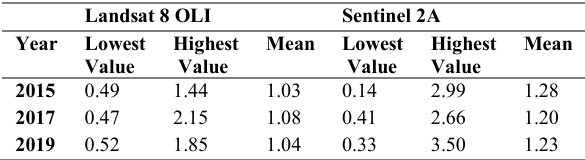
Table 7: MSI Value Ranges for Landsat 8 and Sentinel 2A 3.6 Comparative Analysis of Landsat 8 OLI and Sentinel